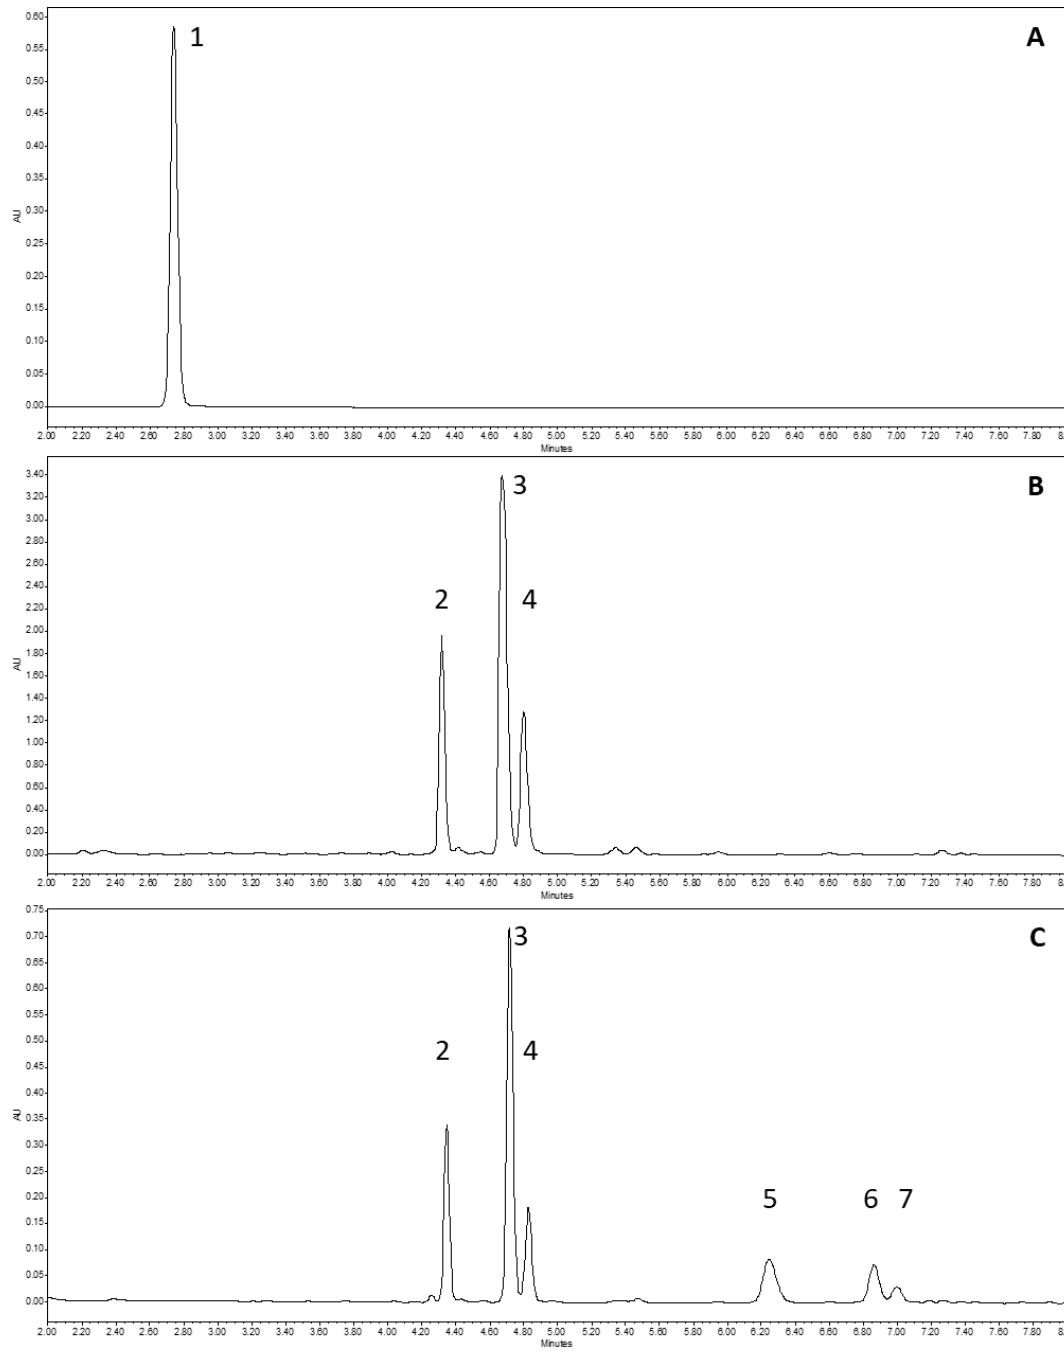
Figure 2. UHPLC-UV chromatograms (330 nm) of xanthohumol ( A ), mix of α -acids ( B ), and mix of αβ -acids ( C ). Identified compounds and their retention times (rt) were: xanthohumol (1) rt 2.78 min, co-humulone (2) rt 4.37 min, humulone (3) rt 4.75 min, ad-humulone (4) rt 4.86 min, co-lupulone (5) rt 6.31 min, lupulone (6) rt 6.92 min, ad-lupulone (7) rt 7.05 min.